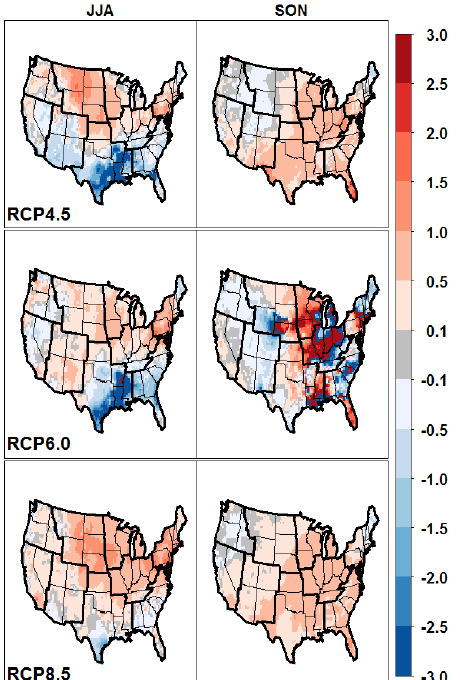
Figure 13. Ratio of projected changes in seasonal MDA8 O 3 to changes in seasonal daily maximum 2m temperature (ppbK − 1 ) for summer and autumn between 1995–2005 and 2025–2035 under RCP4.5, RCP6.0, and